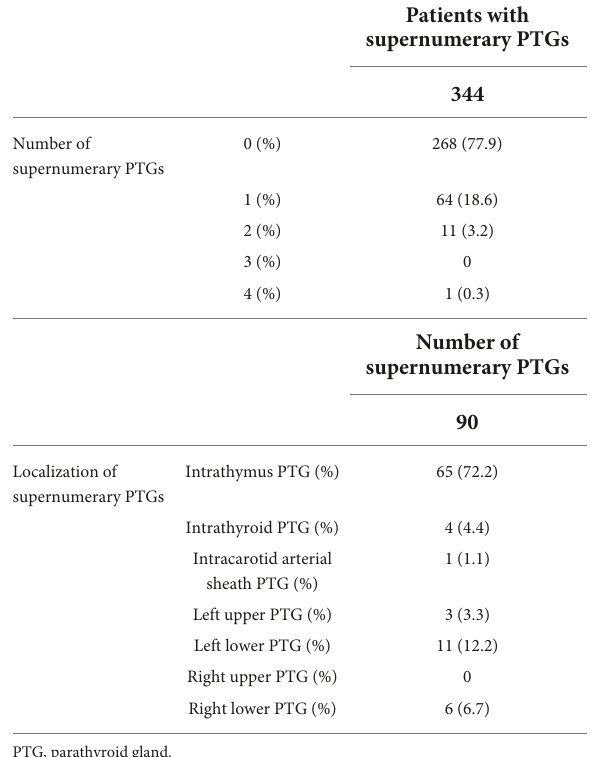
TABLE 11 Diagnostic validity of preoperative imaging studies in all patients.